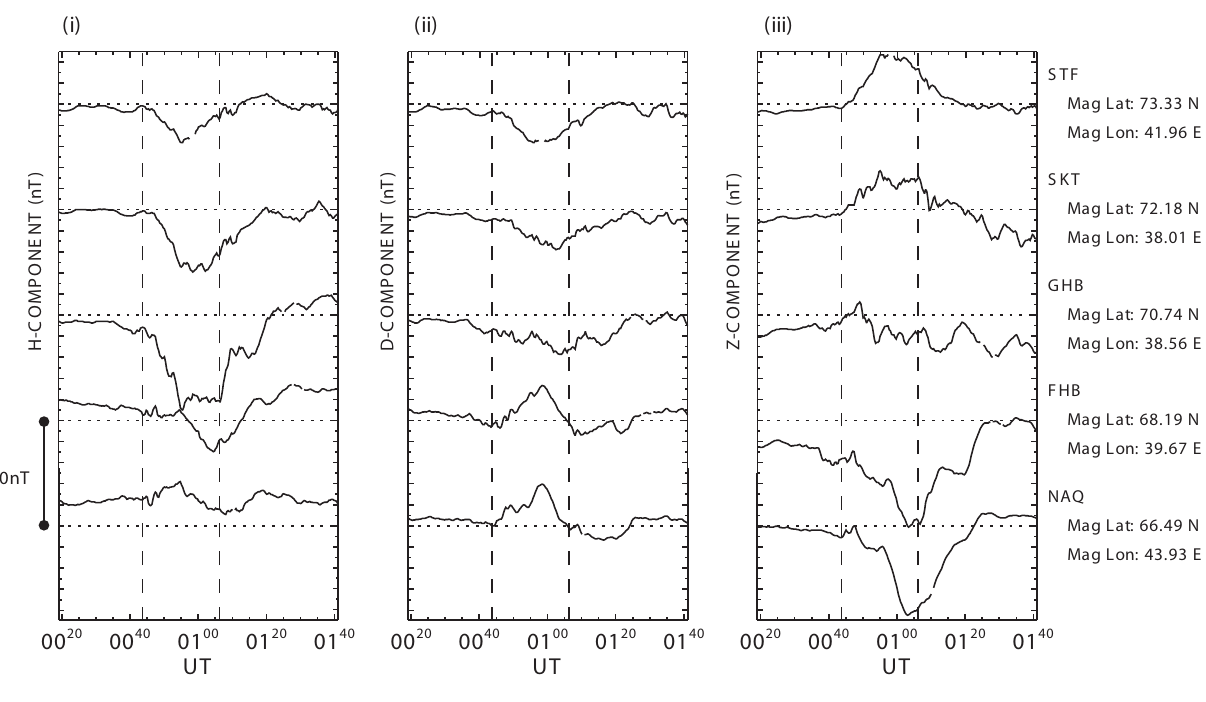
Fig. 3. H,D , and Z -component magnetic field measurements from the meridional Greenland west coast magnetometer array (see Fig. 1b), for 00:20–01:40UT on 2 December 1999. The separation between magnetometer baselines (horizontal dotted lines as in Fig. 2b) is 250 nT. Vertical dashed lines are as in Fig.